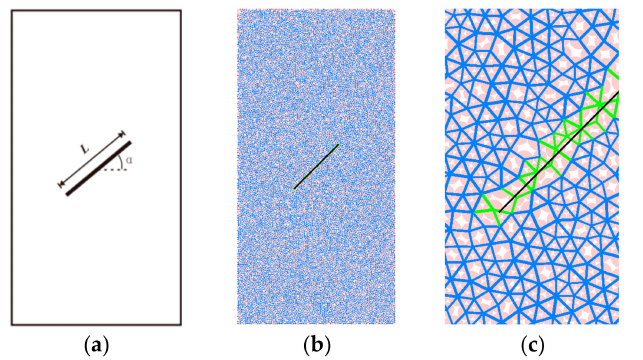
Figure 7. Two-dimensional geometry of the granite with single closed crack in the PFC2D: ( a ) Geo- metric sketch; ( b ) Model with particles and contacts; ( c ) A partial enlarged view of ( b ).